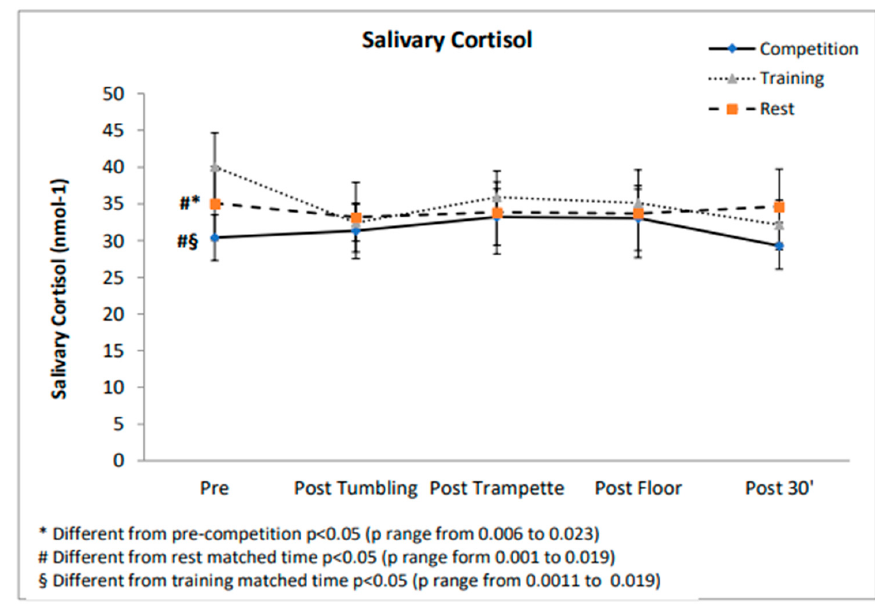
Figure 2. Salivary cortisol values during competition, training and rest